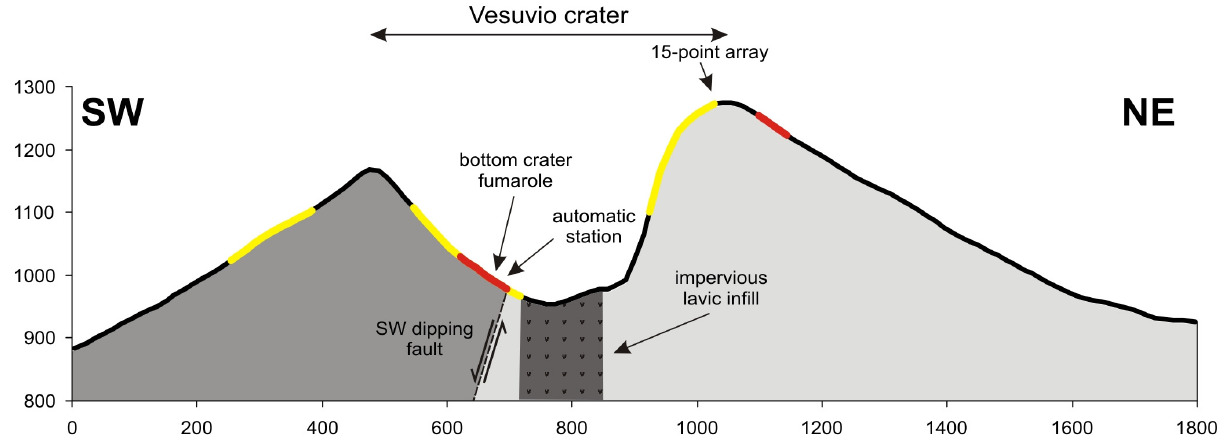
emission in October 2006, 2